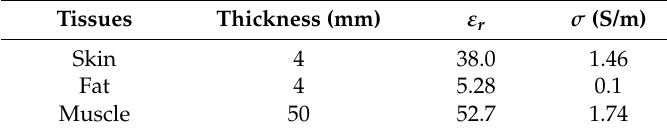
Figure 1. Simulation environment of the proposed antenna. Table 1. Dielectric properties of different tissues at 2.45 GHz . Table 1. Dielectric properties of different tissues at 2.45 GHz.